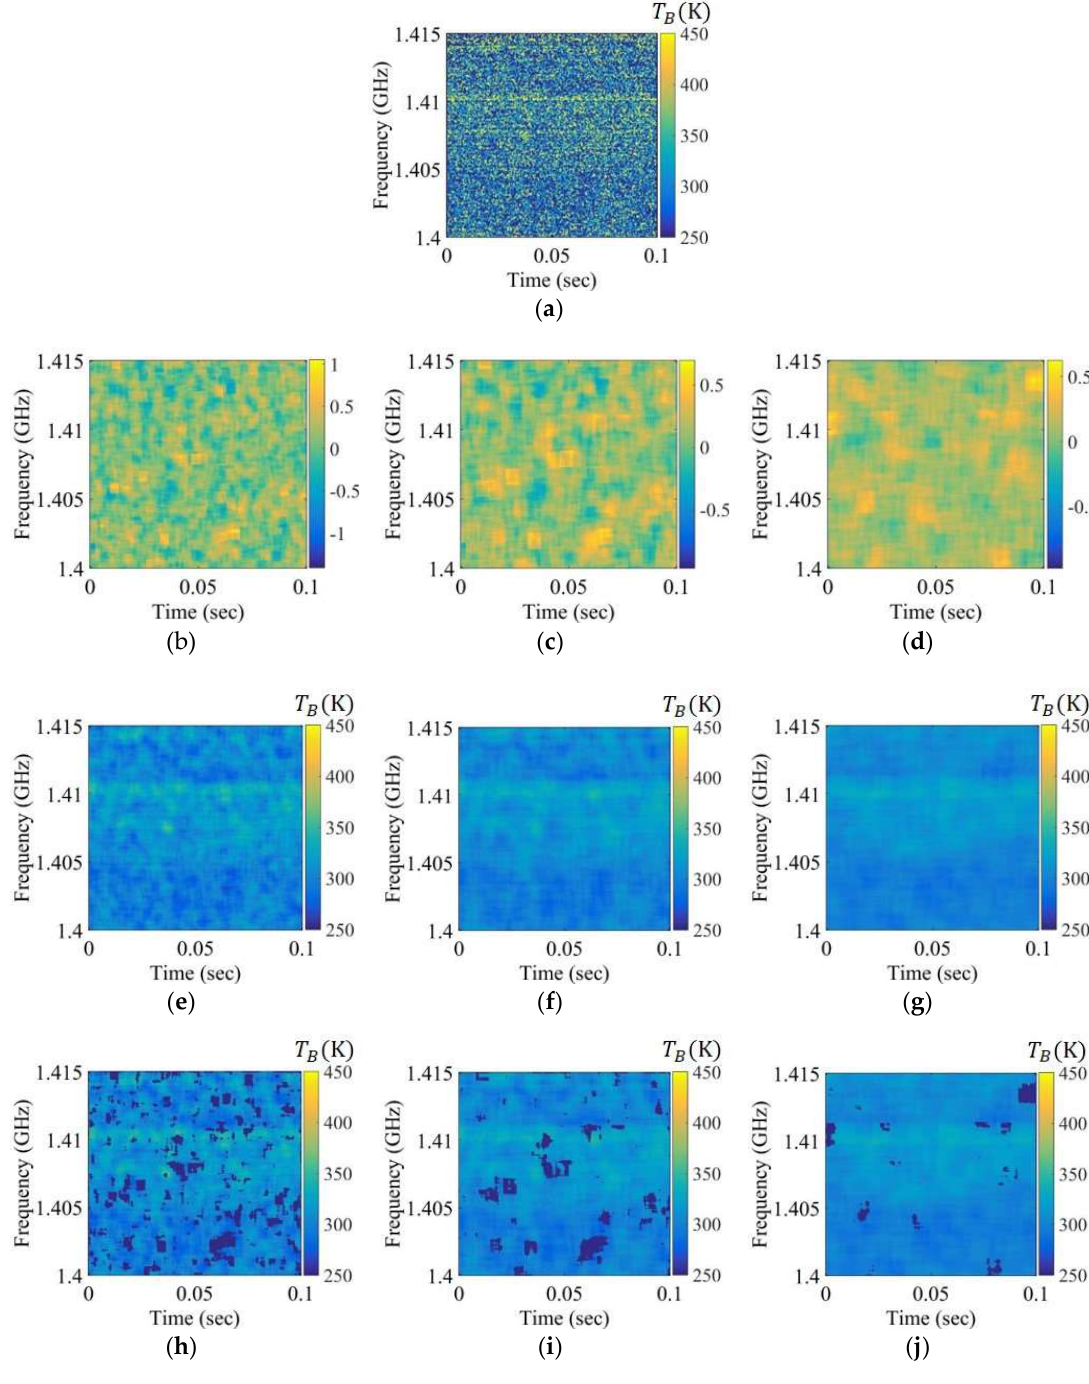
Figure 7. Spectrograms applied to the chirp RFI signal to a level below approximately 10 K over the entire 1.407 to 1.411 GHz band: ( a ) brightness temperature spectrogram after smoothing; ( b – d ) skewness spectrograms obtained using the window sizes of 50 × 50, 75 × 75, and 100 × 100, respectively; ( e – g ) mean spectrograms obtained using the window sizes of 50 × 50, 75 × 75, and 100 × 100, respectively; ( h – j ) mean spectrograms after Step 1 obtained using the window sizes of 50 × 50, 75 × 75, and 100 × 100, respectively.